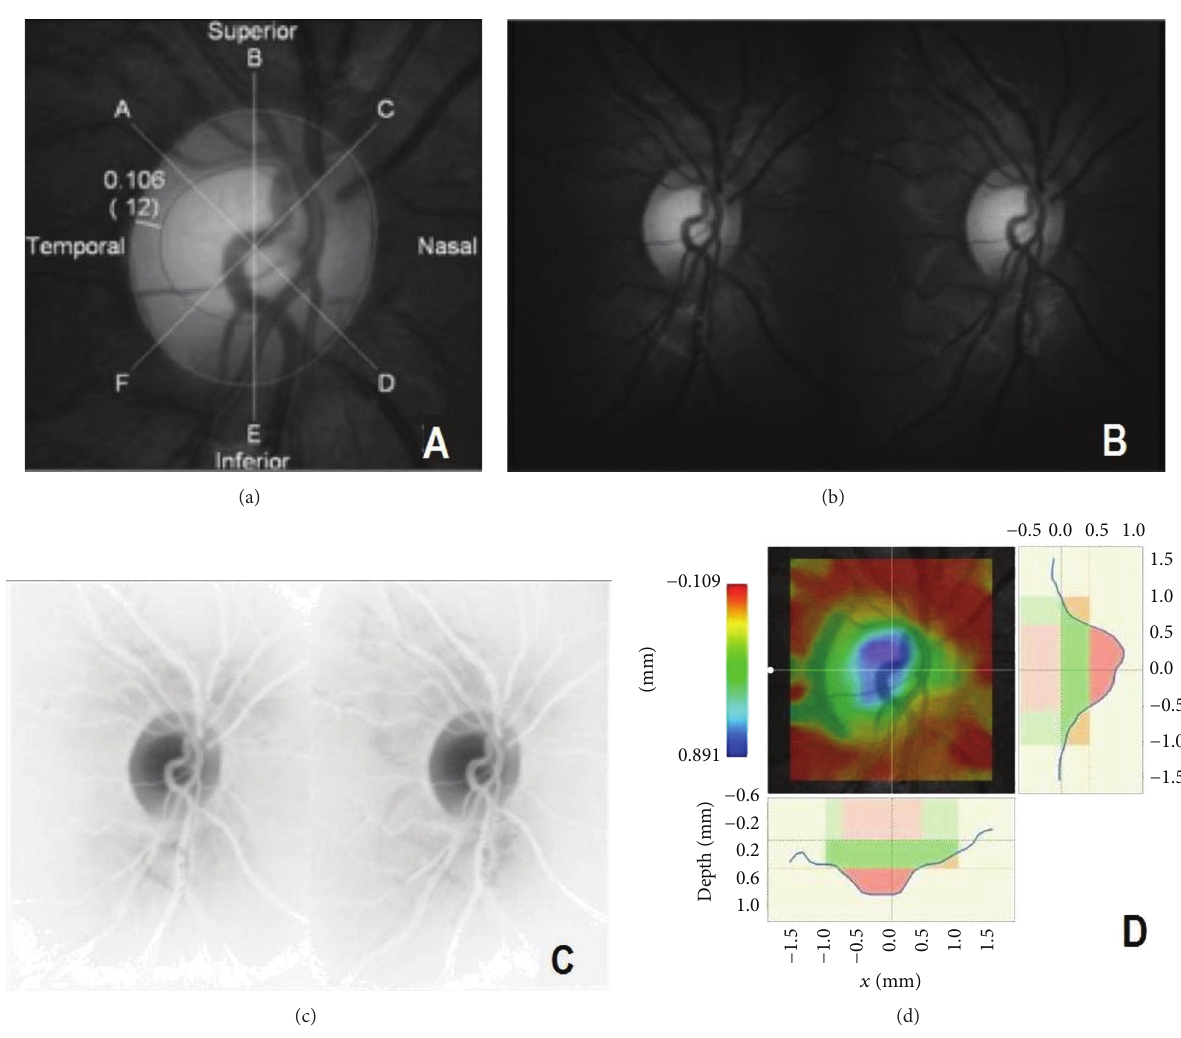
Figure 1: Starting with screening images taken by the nonmydriatic Kowa retinal camera, the CDR was assessed nonstereoscopically to place rim and disc contours (a) with assistance of the green channel (b) and negative image (c). Software generated depth analysis map